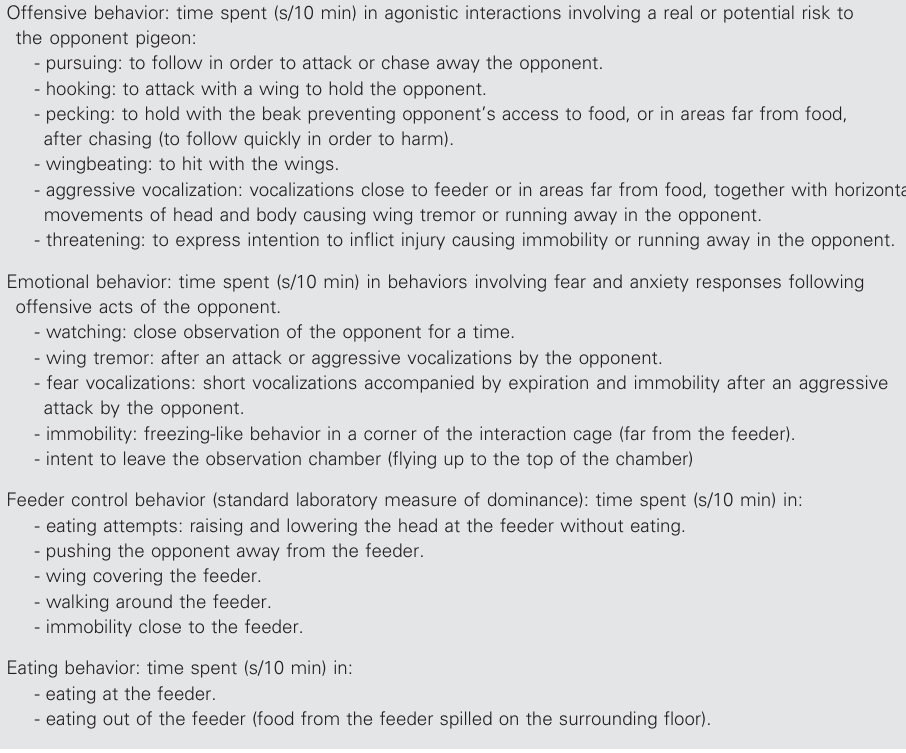
Table 1. Structure of the behaviors selected for